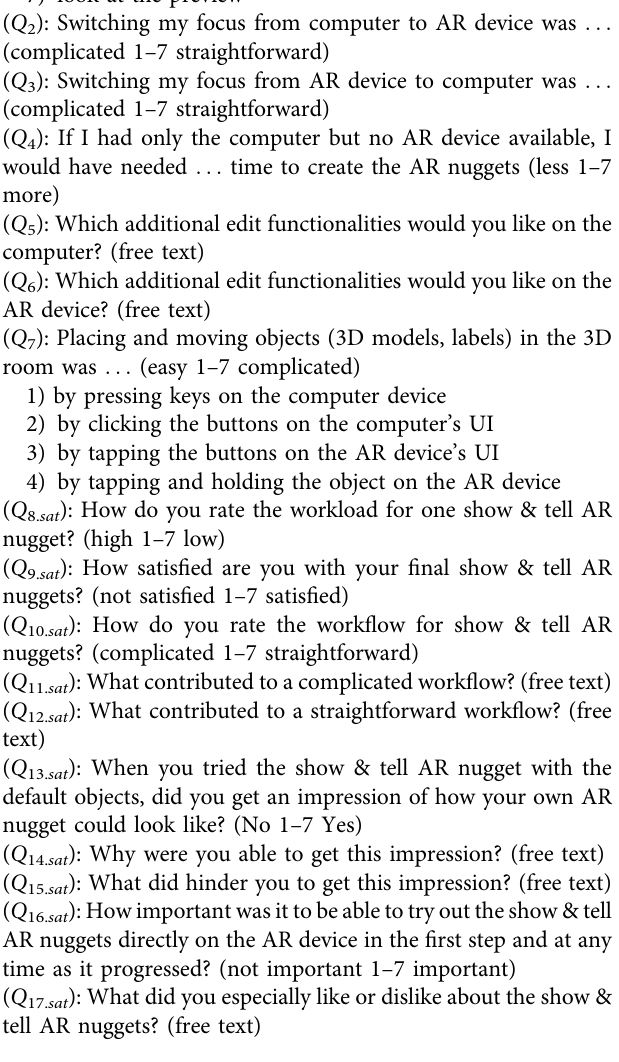
neutral area for hedonic as well as pragmatic qualities. The